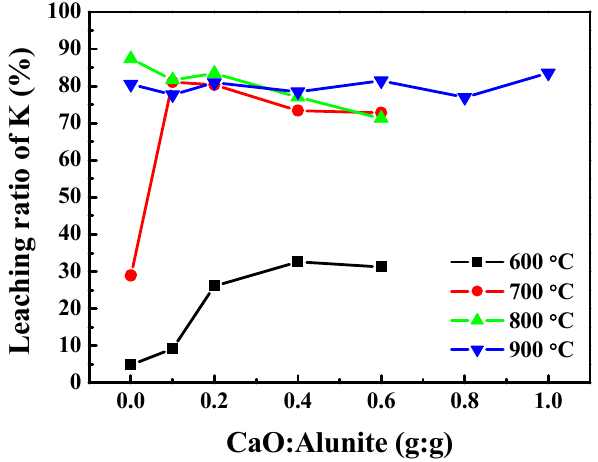
Figure 1. The effect of mass ratio of CaO/alunite on the recovery ratio of potassium.